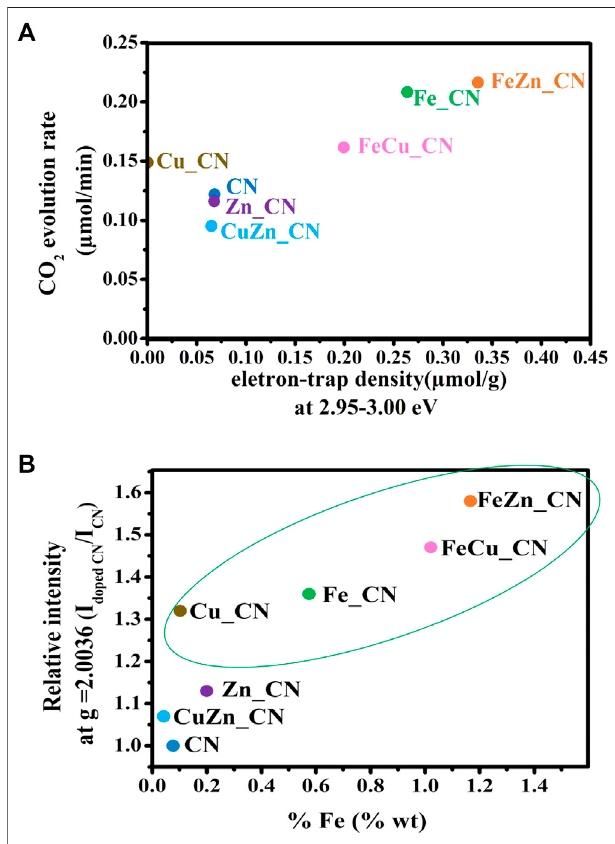
FIGURE 7 | (A) Plot of CO 2 evolution rate vs electron-trap density at 2.95 – 3.00 eV, and (B) the correlation between ESR signal relative intensity at g = 2.0036 and the bulk concentrations of Fe in carbon nitride-based materials. The materials in the green oval gave high CO 2 evolution rates, as de fi ned in Table 2